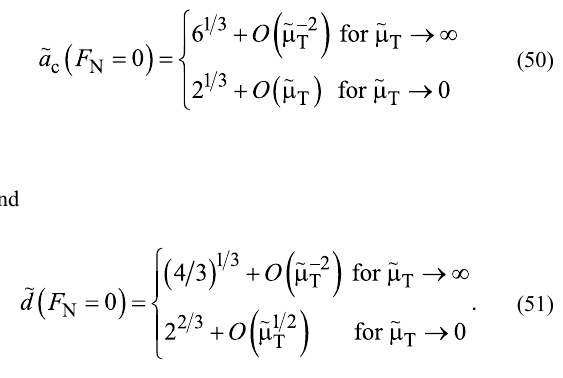
tive errors are small, i.e., ≤ 1% even for μ T ≈ 1, where one is relatively far away from both the DMT and the JKR